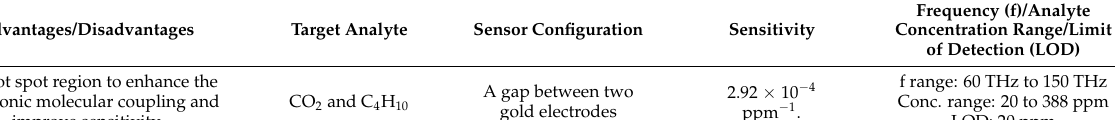
Table 2. Performance comparison of metamaterial-based gas